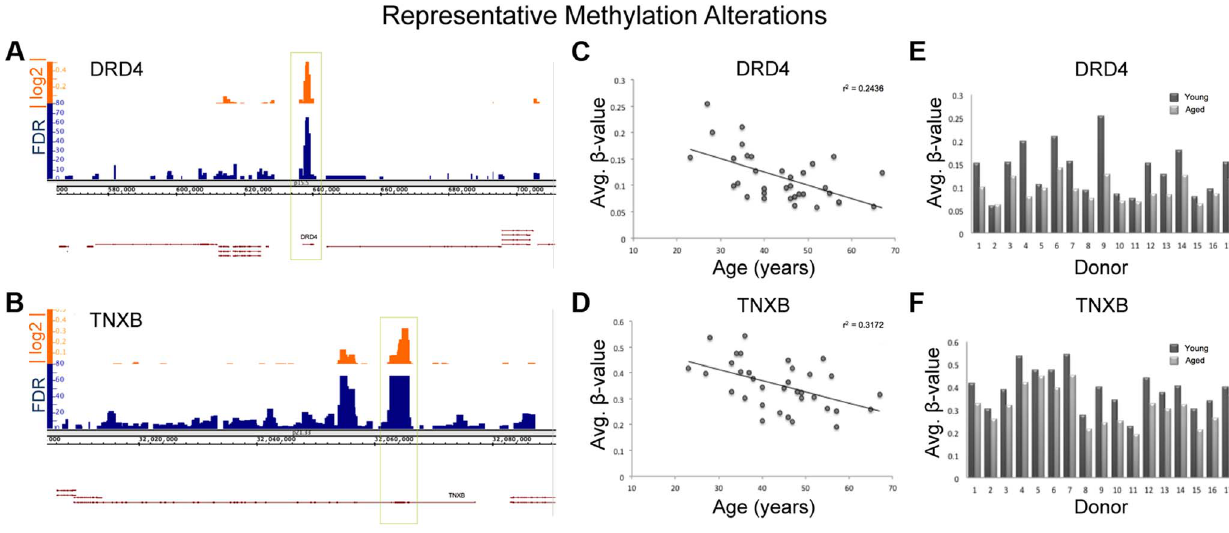
Figure 7. Various descriptive statistics are presented for both TNXB and DRD4; 2 regions of representative methylation alterations. (A,B) The alignment track for each gene is displayed in Integrated Genome Browser (IGB) with the associated false discovery rate (FDR) denoting the significance of the change and the absolute log 2 ratio reflecting the magnitude of the alteration. (C,D) Scatter plots for each sample from all 17 donors (a total of 34 samples with each donor represented twice) with linear regression lines and associated r 2 values were generated. Regression analysis revealed a significant decrease in methylation with age at both DRD4 and TNXB (p=0.0005 and p=0.003 respectively). (E,F) The average methylation within each window (DRD4 and TNXB) was plotted for each paired sample set and is displayed for each donor.